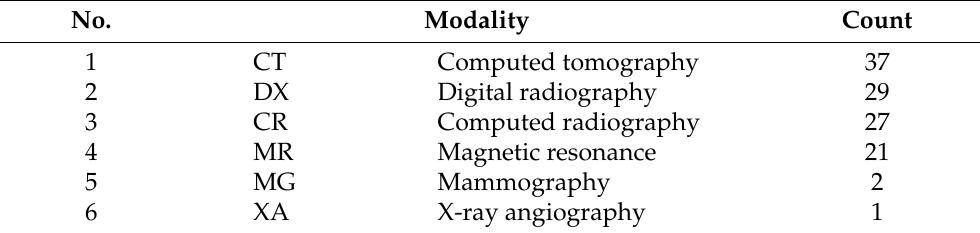
Table 3. Test load: imaging